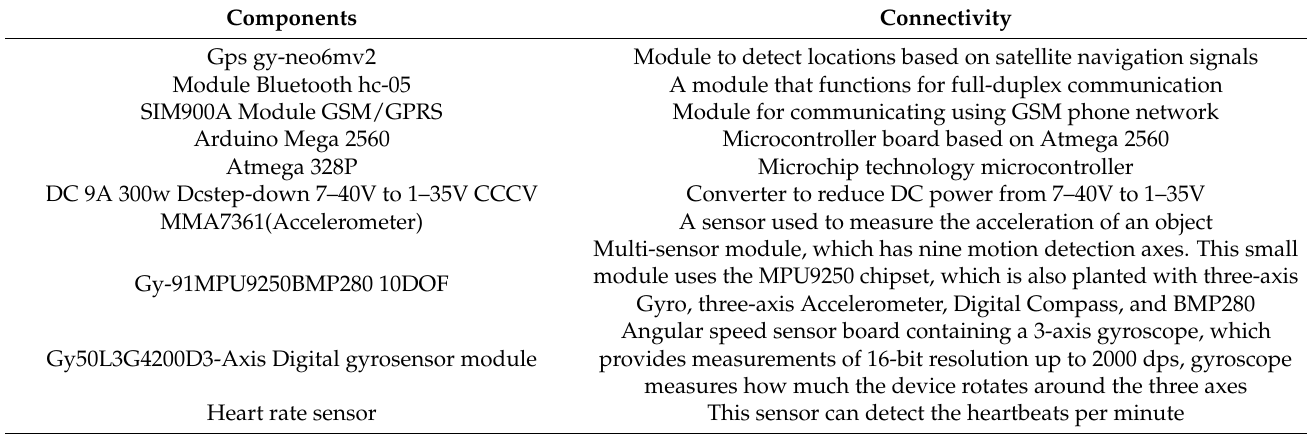
Table 3. Sensor and wearable